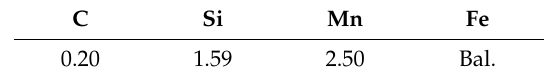
Table 1. Chemical composition (wt.%) of base metal used in this study.